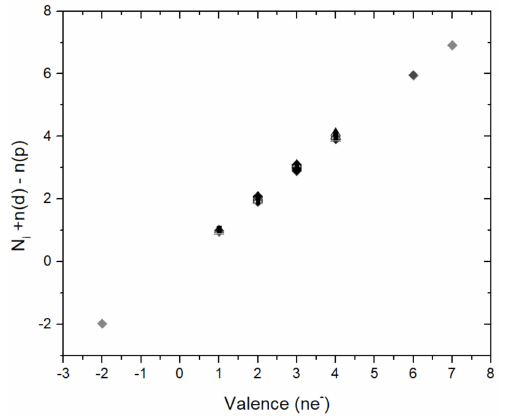
Figure 2. The figure shows that the parameter N in Equation (1) is related to formal valence through the Equation N i + n(d) − n(p) = valence. n(p) and n(d) give the occupation of the valence p- and d-states, respectively. N i runs through the values 1 to 6 that are given in Table